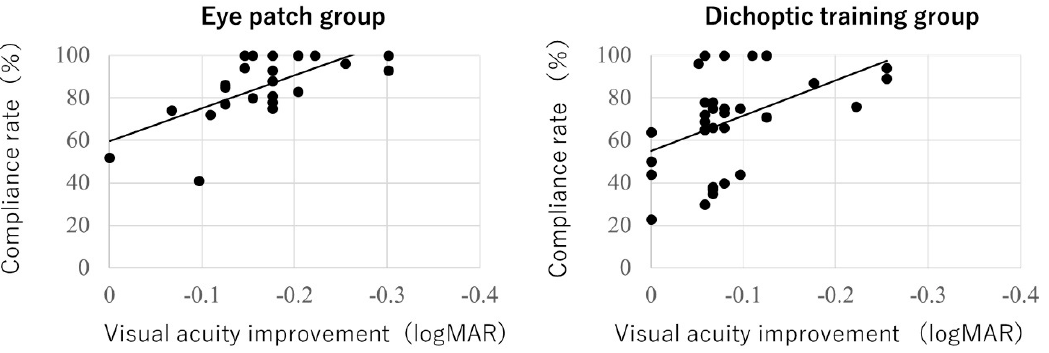
Figure 5. The correlation between the visual acuity improvement and compliance rate. A significant correlation was observed between the visual acuity improvement and the compliance rate in both study groups.